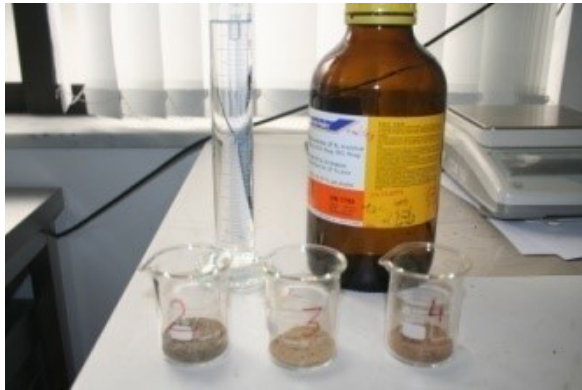
Figure 9: Acid test samples.